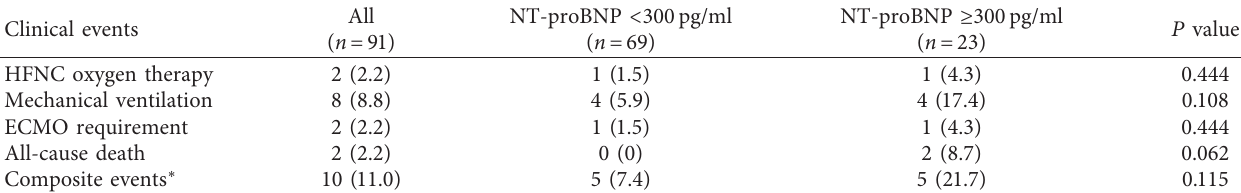
Table 2: Clinical events across plasma NT-proBNP groups.